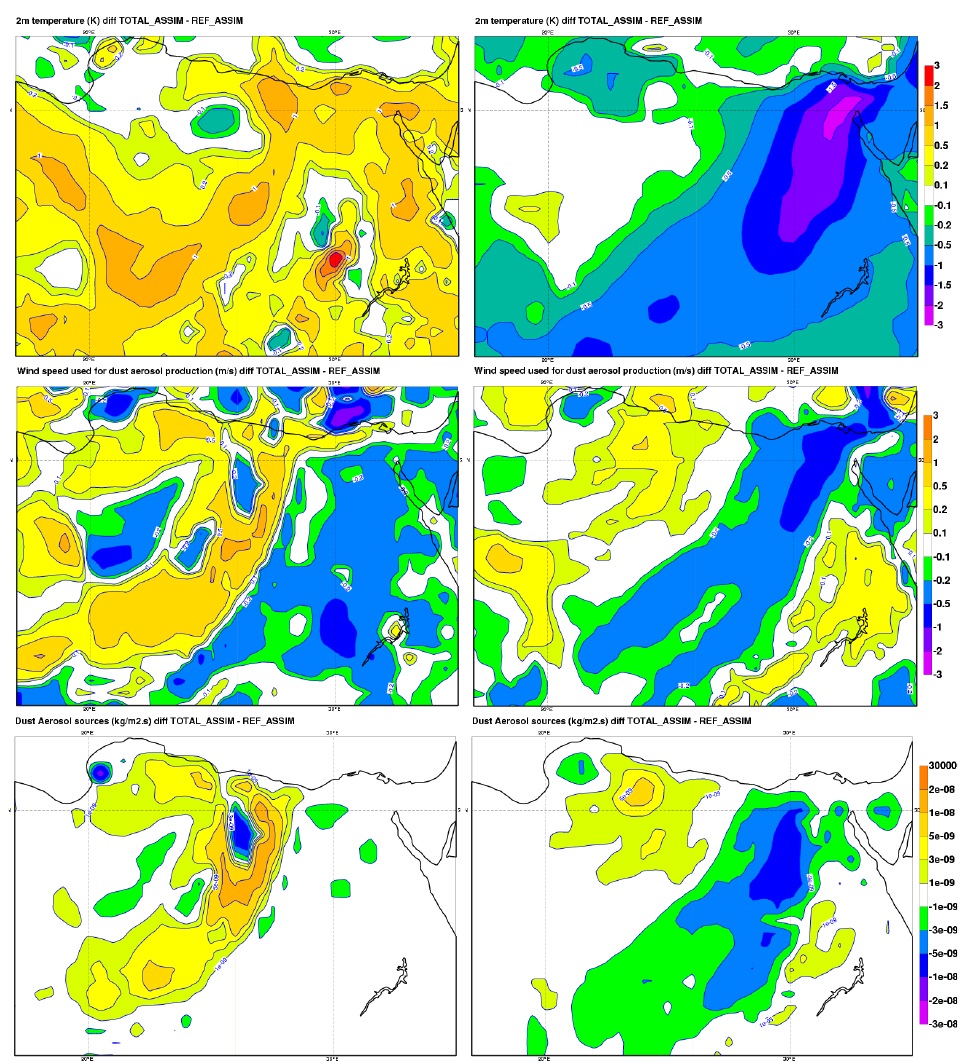
Figure 16. Simulations starting on 17 April 2012, 24h forecast (left) and 36h (right) forecast time. Difference of TOTAL_ASSIM– REF_ASSIM for 2m temperature (top), 10m wind speed (middle) and dust production